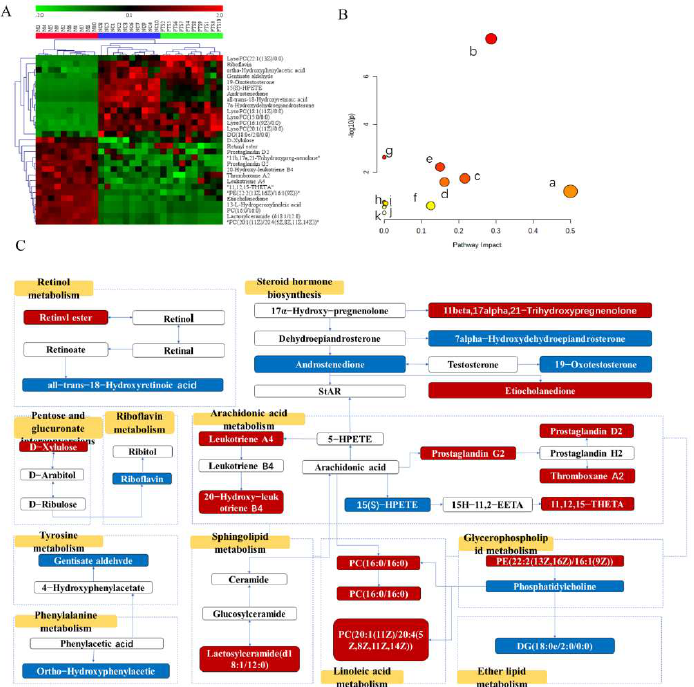
Figure 6. ( A ) Heatmap of biomarkers. ( B ) Effects of PTS on metabolic pathways in UC, where a, riboflavin metabolism; b, arachidonic acid metabolism; c, glycerophospholipid metabolism; d, retinol metabolism; e, steroid hormone biosynthesis; f, pentose and glucuronate interconversion; g, linoleic acid metabolism; h, phenylalanine metabolism; i, ether lipid metabolism; j, sphingolipid metabolism; k, tyrosine metabolism. ( C ) Metabolic network including biomarkers and metabolisms.